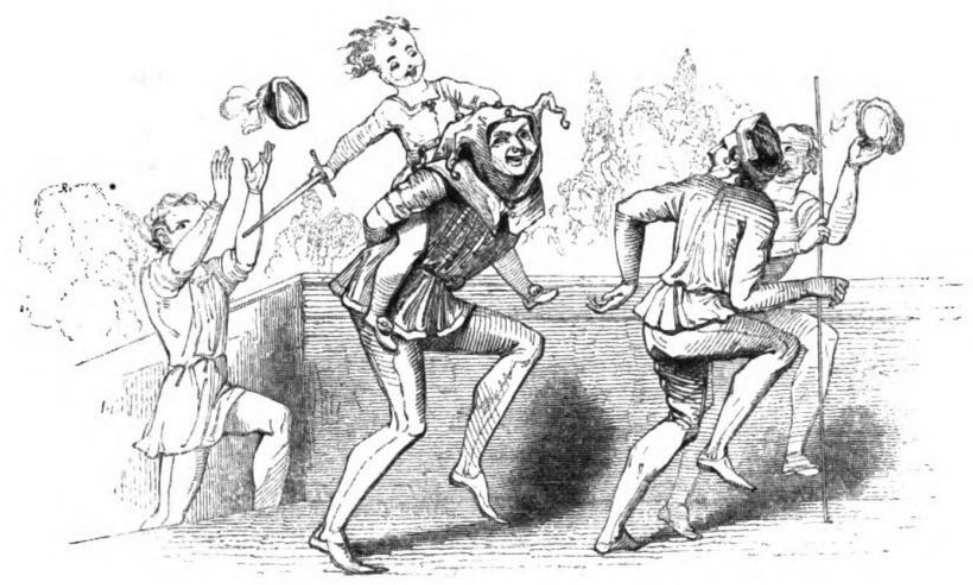
Figure 1. Engraving by Vizetelly Brothers from a drawing by Kenny Meadows, in The Works of Shakspere [sic], ed. Barry Cornwall, London, 1843, 3 vols., II.